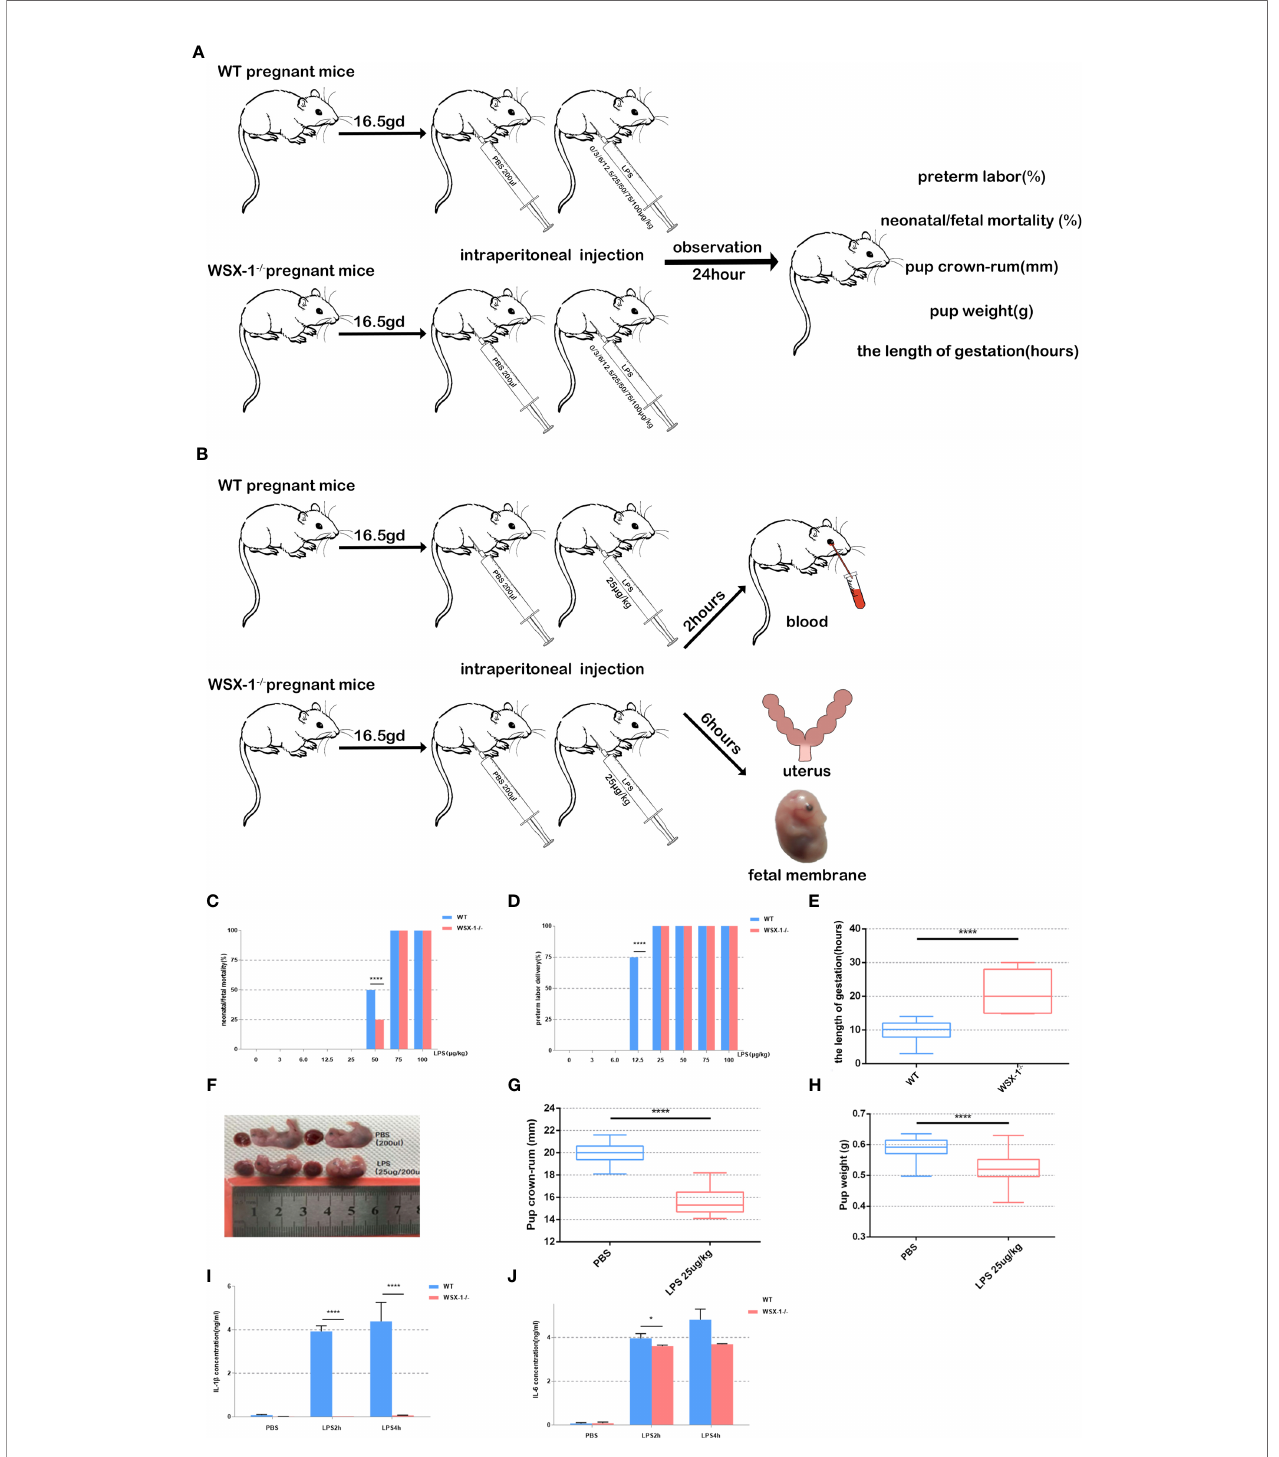
FIGURE 1 | Flowchart showing the mouse model of preterm labor (A, B) . Reduced susceptibility to LPS in WSX-1 -/- mice. Statistical analyses of preterm labor rate and neonatal mortality in WSX-1 -/- and wild-type genotypes when treated with increasing concentrations of LPS for 24 h (0-100 µg/kg) (n = 5 mice for each concentration per group) (C, D) . 16.5gd mice were injected with 25 µg LPS/kg and monitored for delivery with video recordings (E) . Fetal body length and weight of preterm and control fetal mice (E – H) . IL-1 b and IL-6 protein levels in peripheral blood from mice of both genotypes after treatment with different concentrations of LPS treatment (25 µg/kg) (n = 6), as determined by ELISA (I, J) . *P < 0.05, ****P <